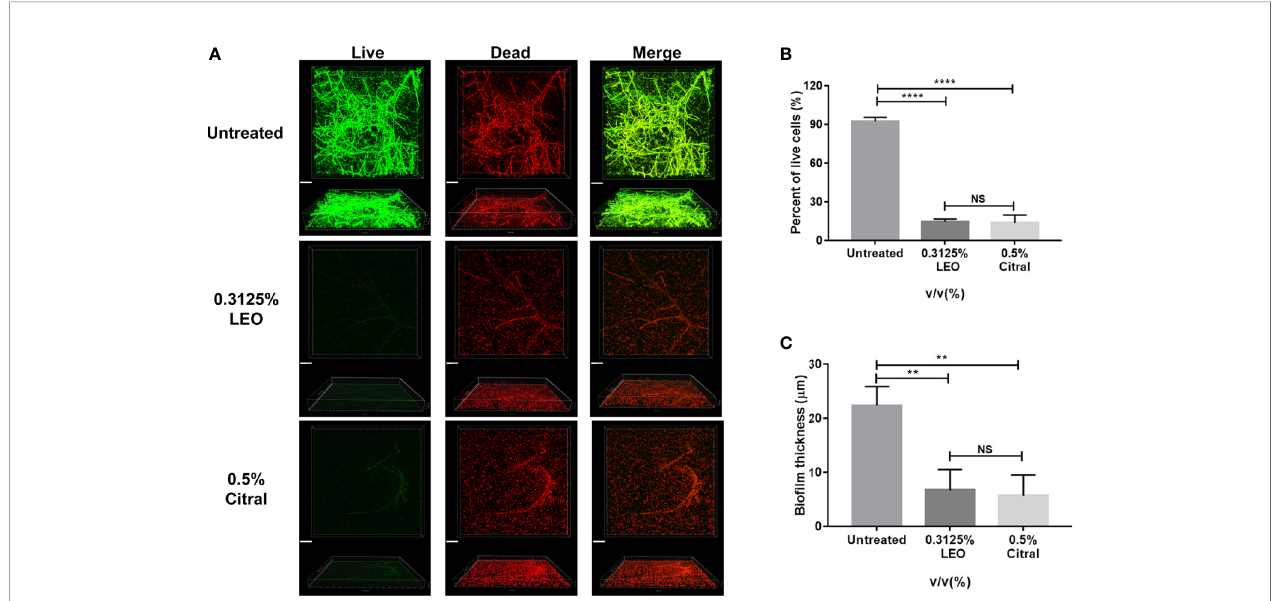
FIGURE 6 | CLSM evaluation of live/dead ratio and bio fi lm thickness after 24 h exposure to lemongrass essential oil or citral. (A) Visualization of dual-species bio fi lms by live/dead cell staining. The upper fi gures show top view and the lower fi gures show side view of bio fi lms. (B) Quanti fi cation of the live cells in dual-species bio fi lms after lemongrass essential oil or citral treatment. (C) Quanti fi cation of the bio fi lm thickness after LEO or citral treatment. The scale bar indicates 20 m m; Data are shown as mean ± SD (n=4), **p < 0.01, ****p < 0.0001, NS, No Signi fi cance.